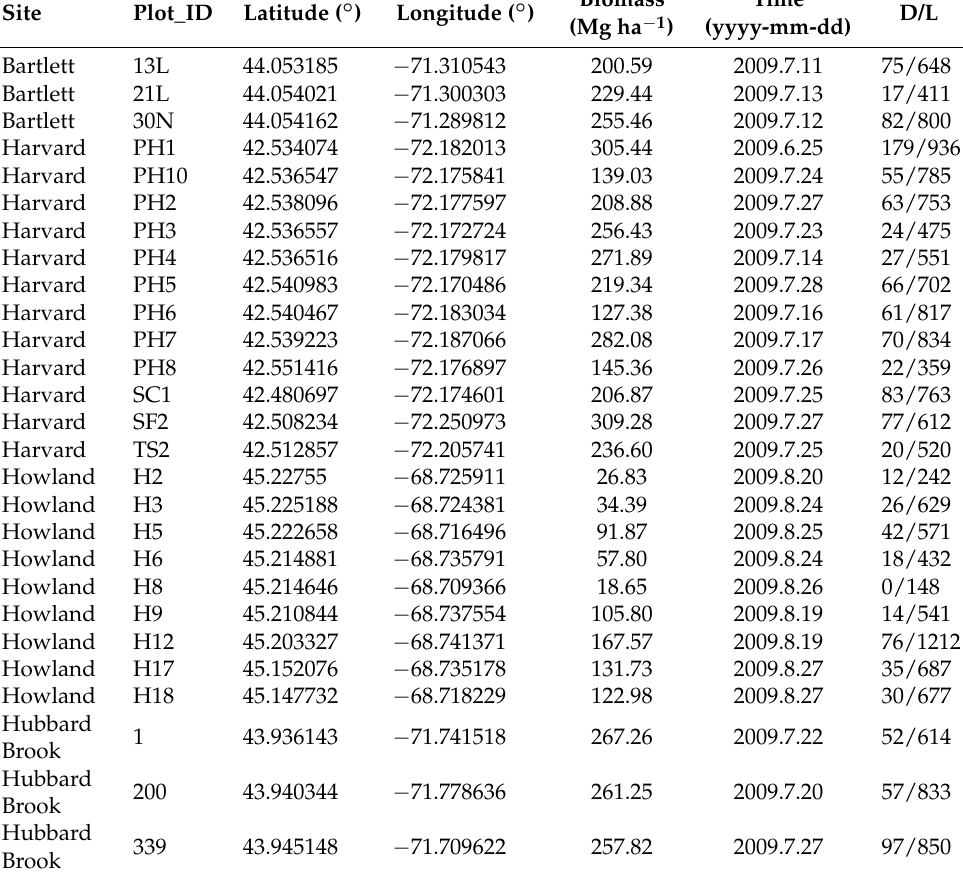
Table A1. The field-measured sites selected in the Howland Forest (lat: 42.20 ◦ , lon: − 68.73 ◦